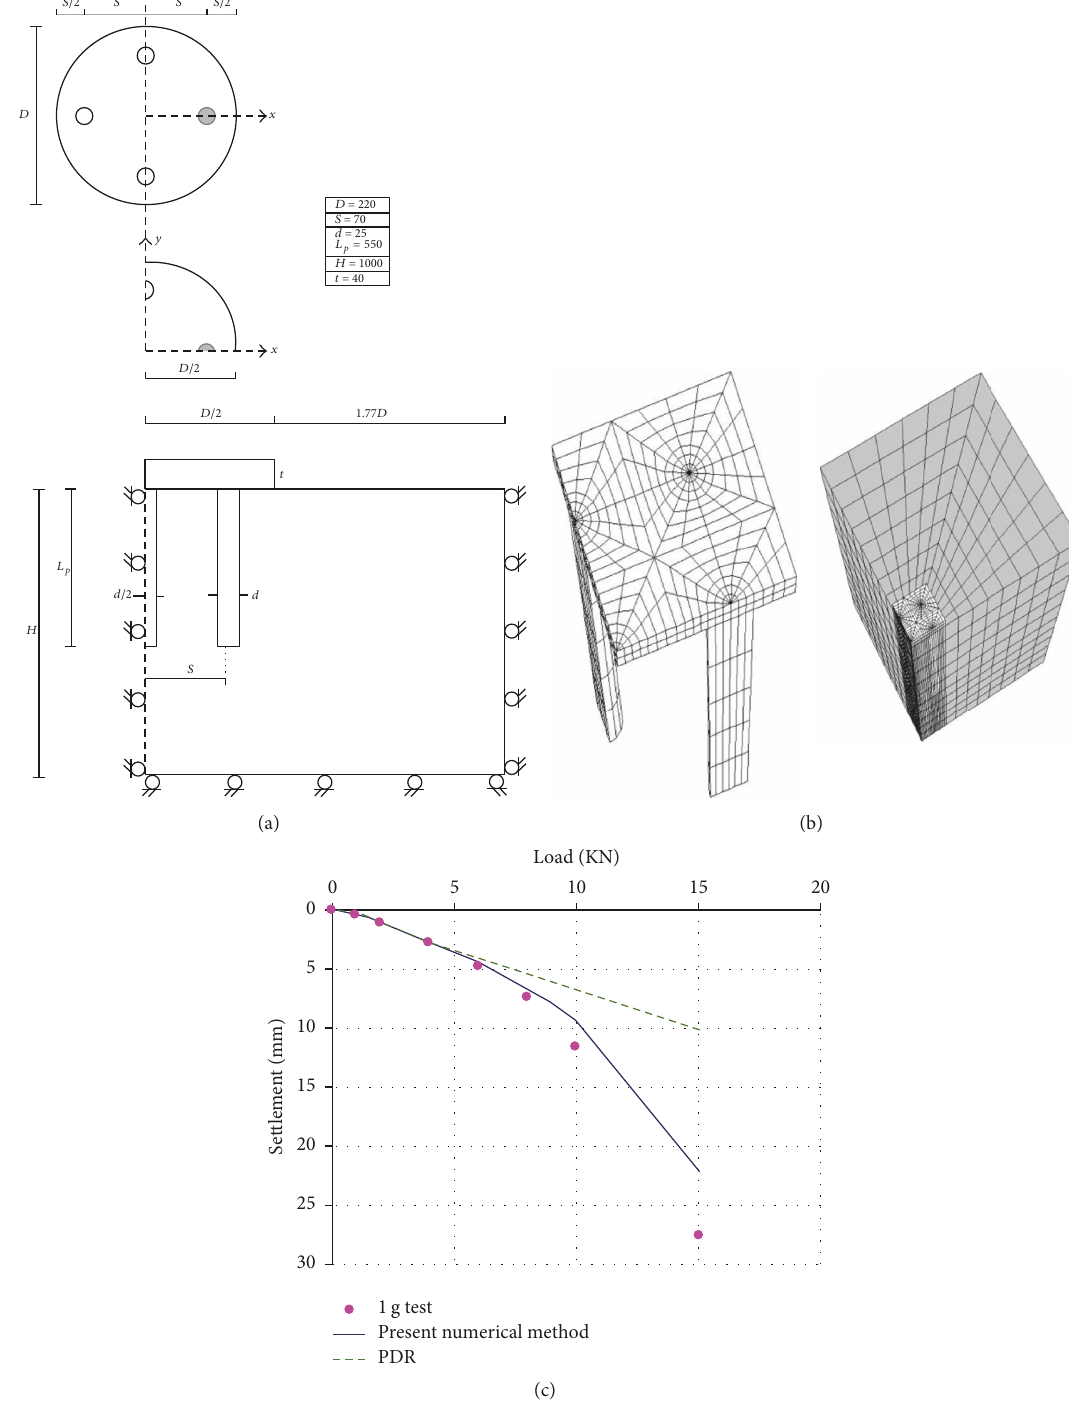
Figure 9: (a) Geometry of conducted physical model. (b) Three-dimensional finite difference mesh. (c) Comparison of the results of finite difference and physical model